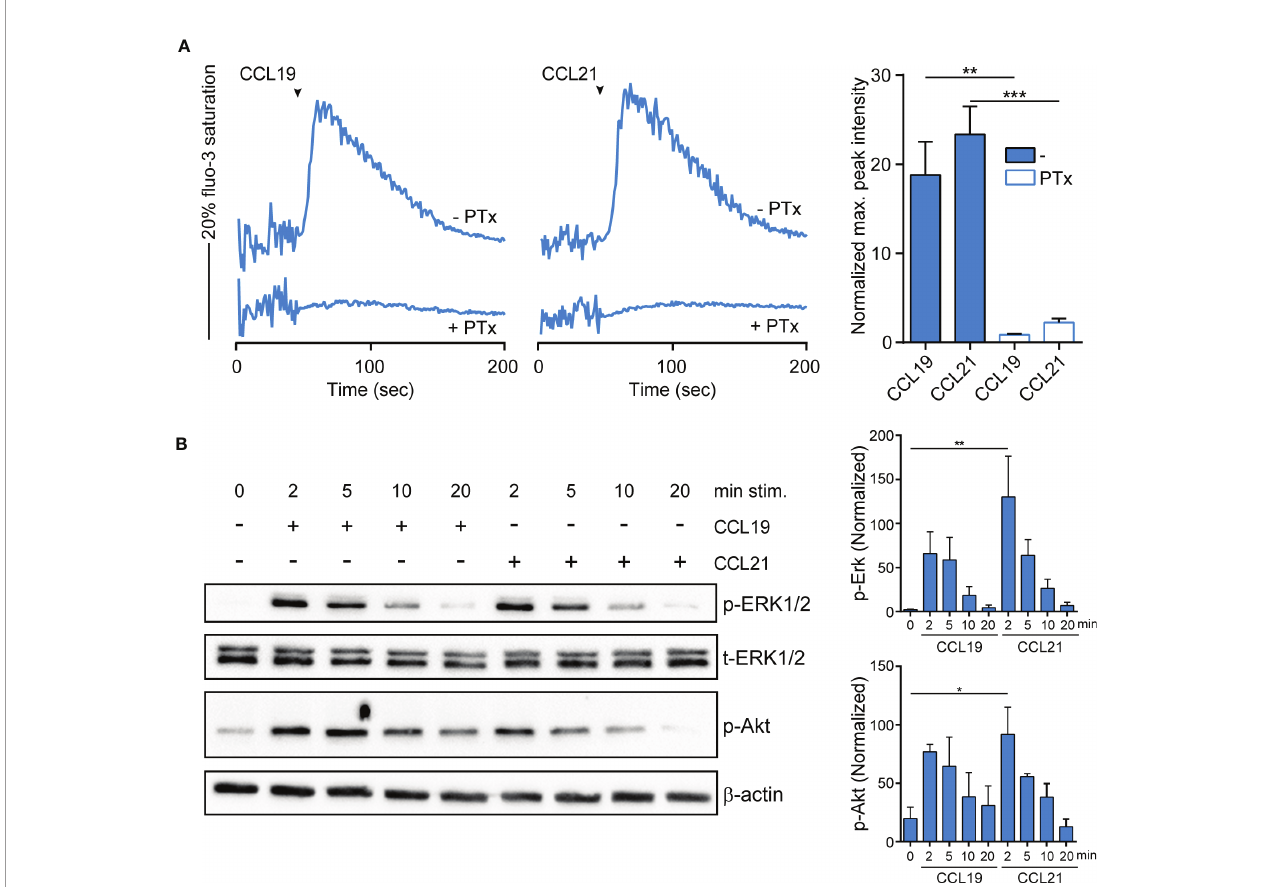
FIGURE 3 | CCR7-mediated calcium mobilization and phosphorylation of ERK1/2 and Akt in R848-matured GM/CAL-1 cells. (A) CCL19/CCL21-induced calcium mobilization in mature GM/CAL-1 cells. R848-matured GM/CAL-1 cells were treated or not with 200ng/ml PTx for 3h, loaded with fl uo-3-AM and stimulated with 30nM of either CCL19 or CCL21. Changes in intracellular calcium levels were recorded by fl ow cytometry over time. Chemokine addition is indicated by arrowheads. One representative (left panels) and mean values ± SEM of 3 independent experiments (right panel) are shown. Maximal peak intensity of chemokine-induced fl uo-3 fl uorescence was baseline corrected and normalized to ionomycin treatment by calculating the mean of ten maximal fl uo-3 fl uorescence values derived from each stimulation condition, respectively. (B) CCR7 triggering results in transient ERK1/2 and Akt phosphorylation. R848-matured GM/CAL-1 cells were stimulated with 100nM of either CCL19 or CCL21 for the indicated time periods. Chemokine-mediated activation of ERK1/2 and Akt was determined by Western blotting. Phosphorylation was determined using antibodies recognizing the phosphorylated forms of Thr202/Tyr204 of ERK1/2 (p-ERK1/2), and the phosphorylated form of S473 of Akt (p-Akt). Antibodies recognizing total ERK1/2 (t-ERK) and b -actin served as control for equal protein loading. One representative (left panel) and mean values ± SEM of 3 independent experiments (right panel) are